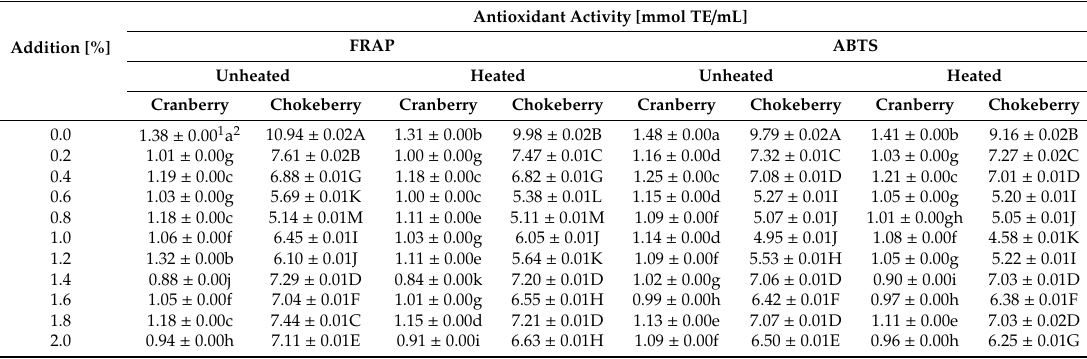
Table 5. The antioxidant activity of products. ABTS: 2,2 (cid:48) -azinobis(3-ethylbenzothiazoline-6-sulfonic acid), FRAP: ferric reducing antioxidative